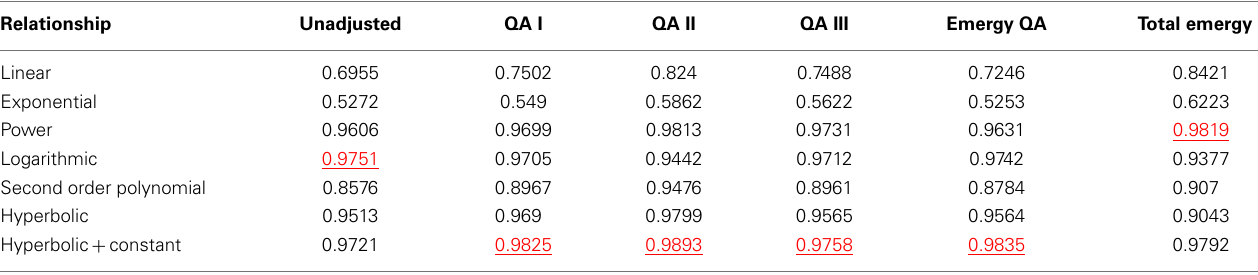
Table 5 |The R -squares of mathematical relationships between measures of energy and quality adjusted (QA) energy consumed or total emergy used (Y) and nominal GDP (X) .